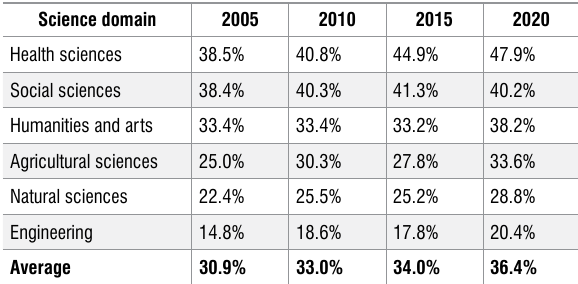
Comparison of share of female (co)authored publications by